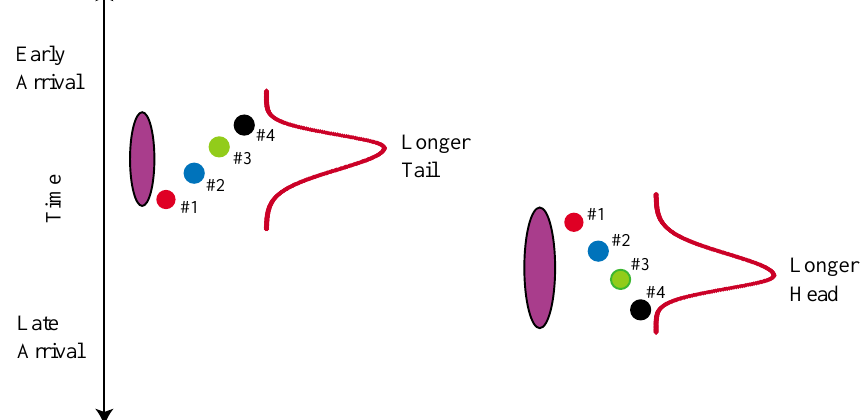
FIG. 23. (Color) This figure displays the dynamics of the bunches in a train. A positive time deviation means the bunches in a train arrive late and the train bunch distribution has a longer head. The mode of oscillation is described for current between 183–276 mA when the oscillation mode is the accordion